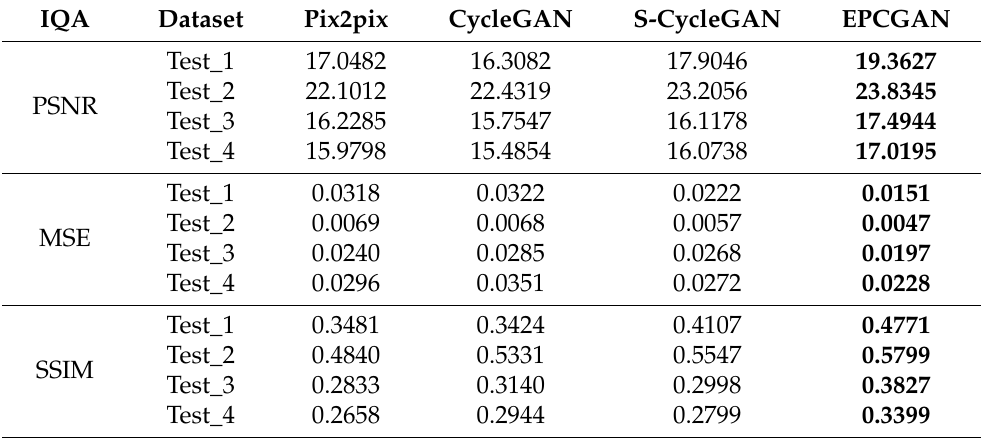
Table 2. Image quality assessment (IQA) results of different methods. The best values for each quality index are shown in